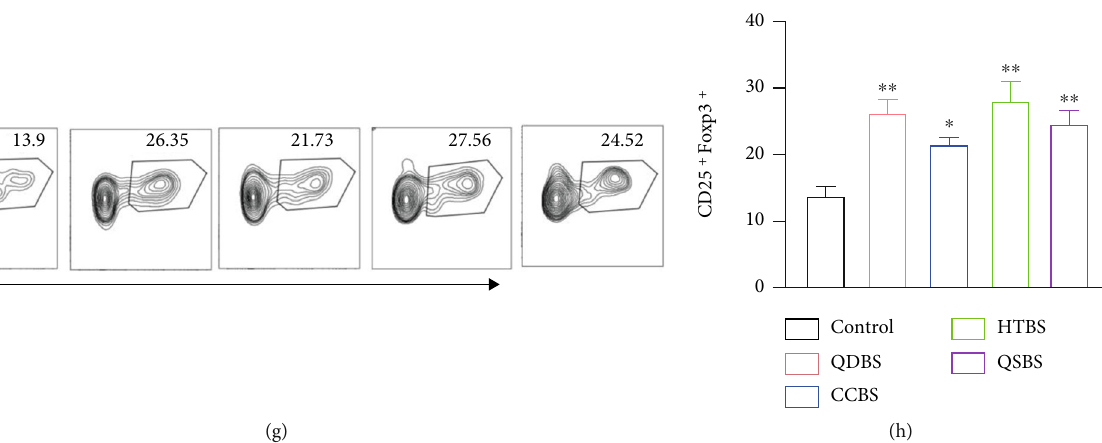
Figure 4: E ff ect of blood stasis syndrome on the tumor microenvironment. (a, b) Flow cytometry showing the percentage of myeloid- derived suppressor cells (CD11b + F4/80 - ) and tumor-associated macrophages (TAMs) (CD11b + F4/80 + ) in the tumor tissues. (c, d) Flow cytometry showing the percentage of M1-TAMs (CD86 + CD206 - ) and M2-TAMs (CD86 - CD206 + ) in the tumor tissues. (e, f) Flow cytometry showing the percentage of CD8 + T cells in the tumor tissues. (g, h) Flow cytometry showing the percentage of regulatory T cells (CD4 + CD25 + FoxP3 + ) in the tumor tissues. ∗ P < 0 : 05 , ∗∗ P < 0 : 01 , and ∗∗∗ P < 0 : 001 , vs.